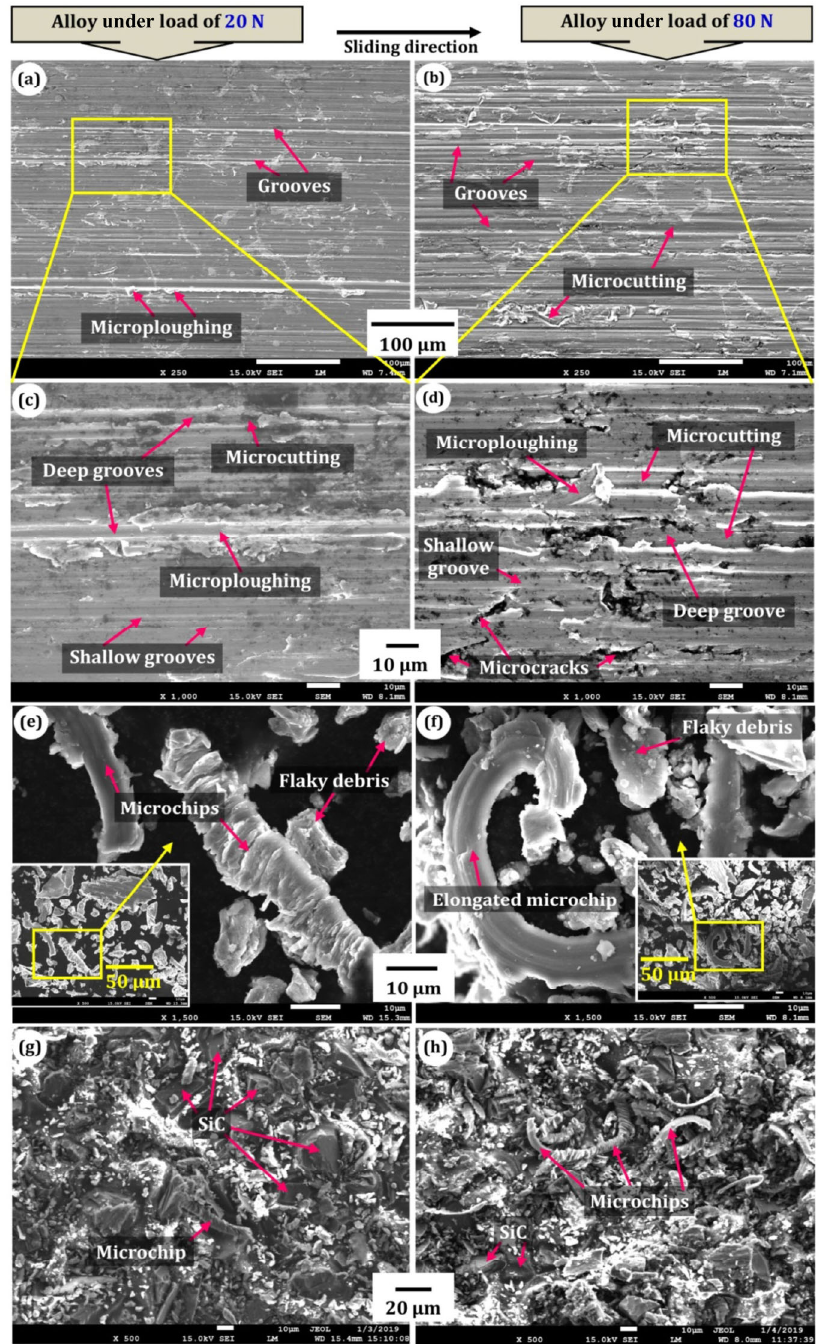
Fig. 5 FE SEM micrographs illustrating the effects of load on the characteristics of abraded surfaces (a − d), generated debris (e–f), and abraded SiC emery papers (g–h) for unreinforced alloy against 23 μ m sized SiC abrasives covering a sliding distance of 20 m with a velocity of 0.5 m·s − 1